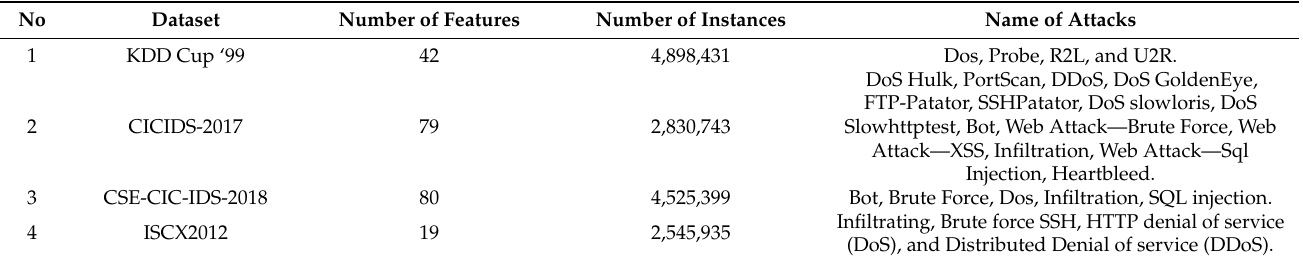
Table 5. A statistical overview of the real-world